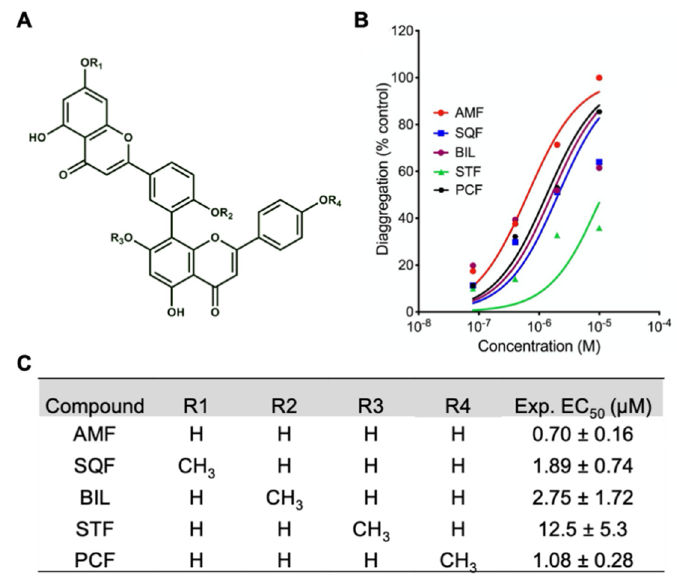
Figure 2. Thioflavin ( ThT) assay disaggregation results from five biflavonoids. ( A ) Generic bi- flavonoid structure. R-groups for the different biflavonoids investigated in this study can be found in ( C ). AMF: amentoflavone; SQF: sequoiaflavone; BIL: bilobetin; STF: sotetsuflavone; PCF: podocar- pusflavone. ( B ) Disaggregating activity of biflavonoids on pre-formed A β 42 fibrils. A β 42 fibrils (20 μ M) were incubated with ThT (5 μ M) in the presence of various concentrations of test compounds. Percent changes in fluorescent intensity of ThT vs. concentrations of the compounds were plotted. ( C ) The half-maximal effective concentration (EC 50 ) values of the test compounds on disaggregation of A β fibrils were calculated and presented as mean ± S.E.M.